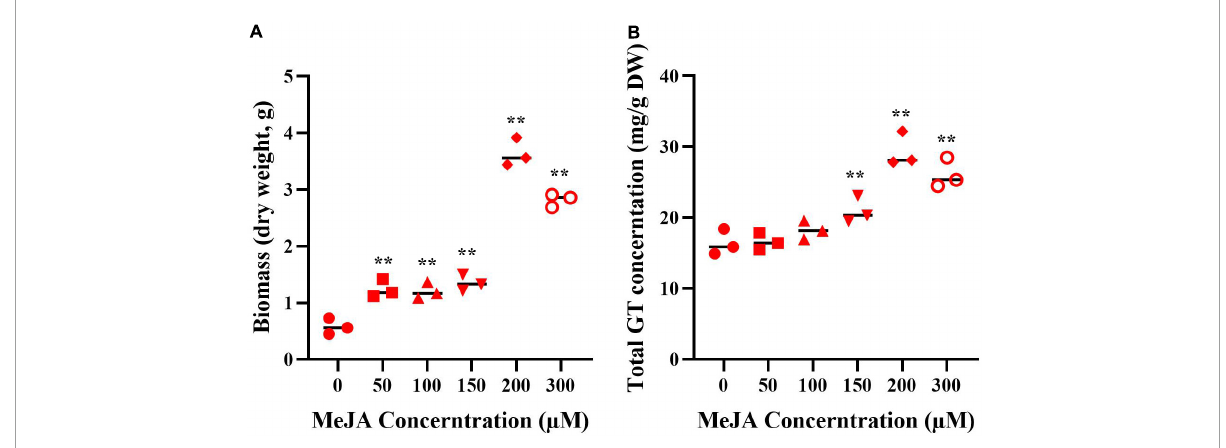
FIGURE2 The biomass (A) and GT content (B) of G. lucidum in response to MeJA treatment. One-way analysis of variance (ANOVA) followed by a post-hoc Tukey test. ∗∗ Means extremely significant difference between treatment and control, p -value < 0.01.